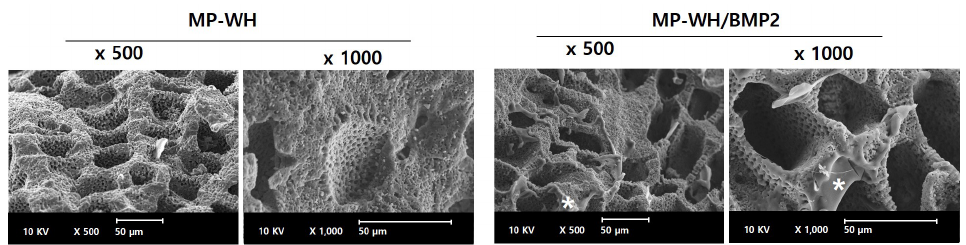
Figure 2. SEM images of BMP2-incorporating marine-plankton-derived WH granules. The images reveal that BMP2 irregularly covers the granules’ surface. Asterisks indicate the fraction of incorpo- rated BMP2.